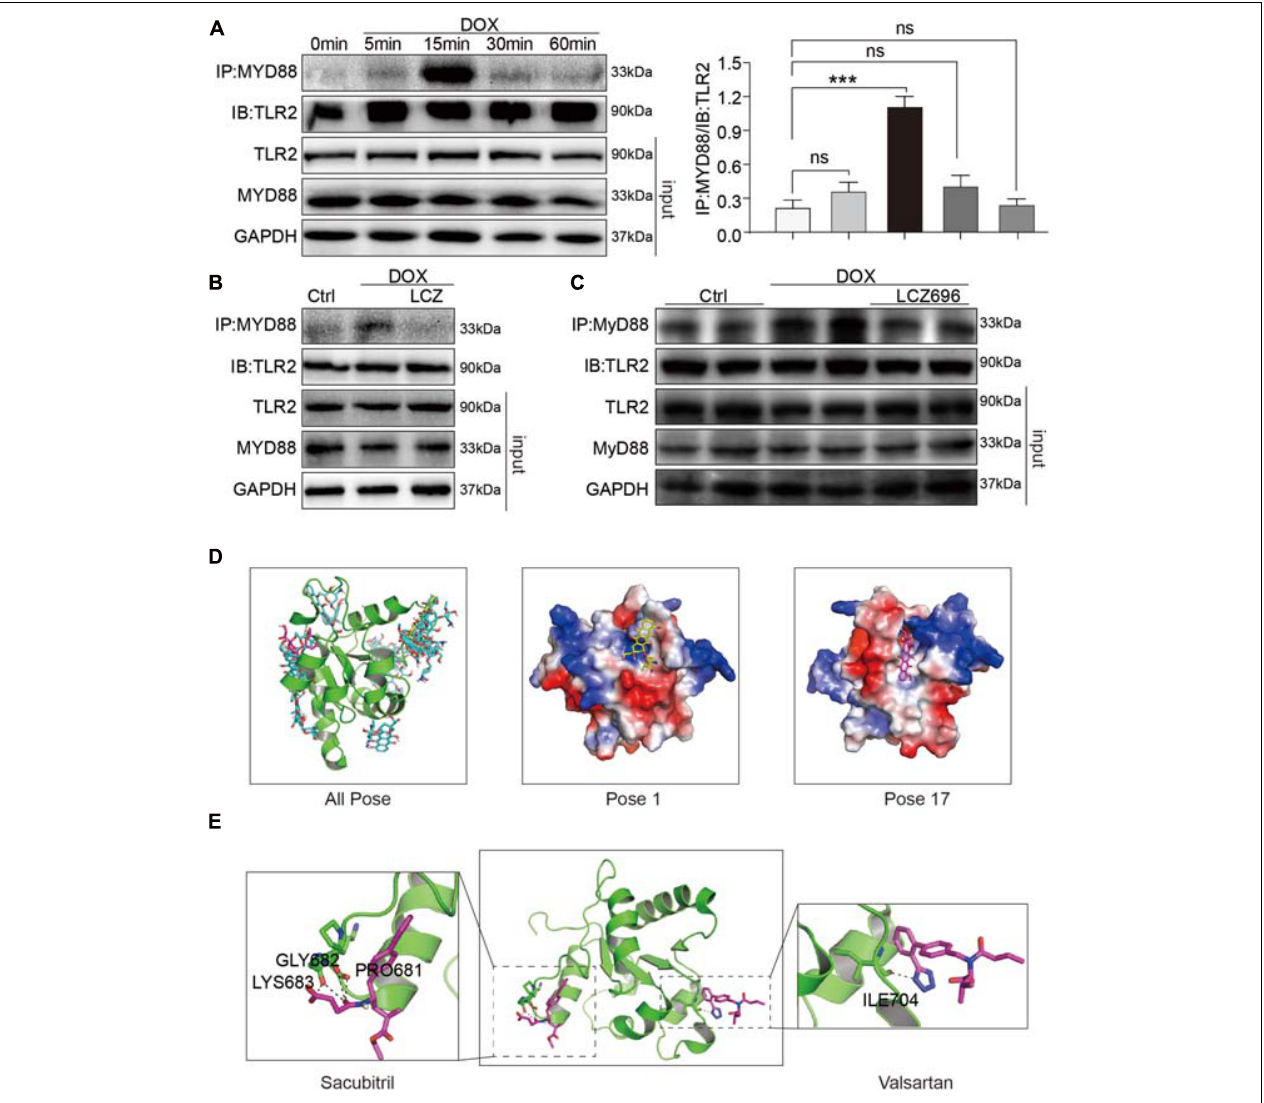
FIGURE 6 | LCZ696 treatment attenuated doxorubicin-induced cardiac injury by inhibiting TLR2-MyD88 complex formation. (A) Time course of the DOX-induced TLR2-MyD88 interaction in H9C2 cells. Cells were treated with 1 µ M DOX for up to 1 h. Quantification is shown below. (B) H9C2 cells were pre-treated with LCZ696 (20 µ mol/l) for 1 h and then stimulated with DOX (1 µ M) for 30 min. The TLR2-MyD88 interaction was analyzed. (C) A co-immunoprecipitation assay determined the TLR2-MyD88 interaction in mice heart tissues. (D) The total of 20 binding conformations (right) are produced by the docking program QVina-W, of which pose 1 (marked yellow) has the best docking score. The details of the binding pose of DOX with the lowest binding energy for TLR2-TIR is shown in the middle, and the details of the binding pose of DOX with TLR2-TIR calculated by MM/GBSA method is shown in the right. (E) The details of the binding pose of LCZ696 (Sacubitril-right and Valsartan-left) with the lowest binding energy is shown for TLR2-TIR. Magenta is the optimal conformation for scoring (unit is kcal/mol). *** P < 0.001 compared to ctrl.